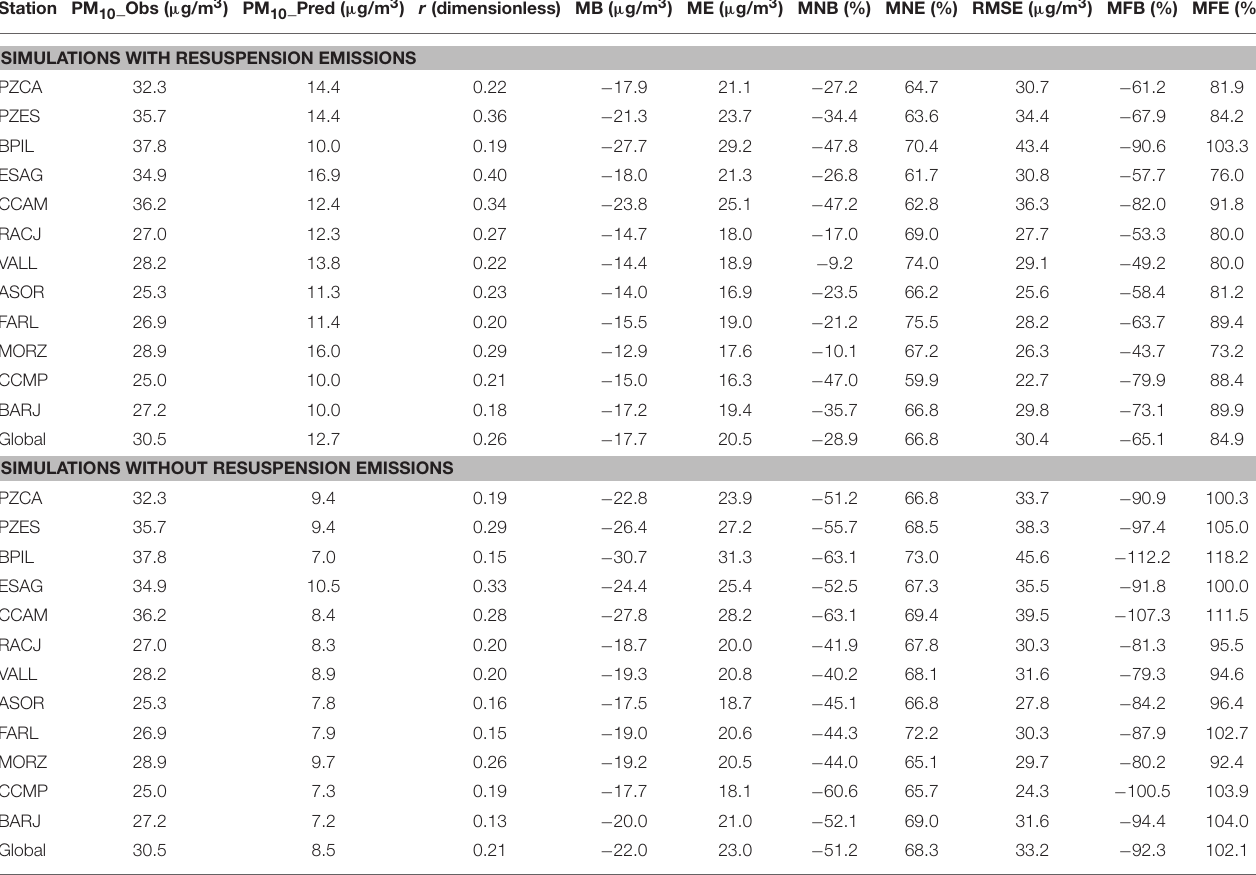
TABLE 5 | Statistics of PM 10 for CMAQ simulations with resuspension emissions and without resuspension emissions.